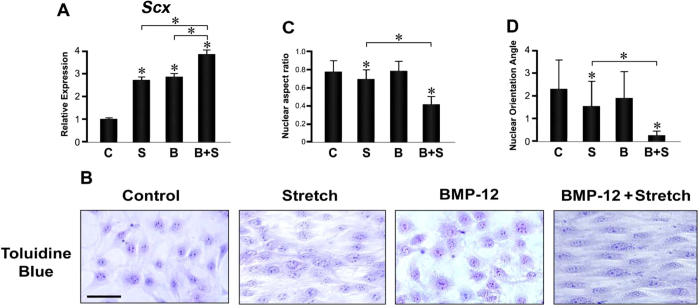
Compound effects of BMP-12 and cyclic loading on the tenocytic differentiation of C3H10T1/2 stem cells.(A) Induced expression of Scx by BMP-12 and cyclic stretch loading. Cells were left untreated or treated with BMP-12 alone, or cyclic loading alone, or BMP-12 plus cyclic loading. After incubation, cells were harvested and analyzed for Scx mRNA expression by RT-qPCR. Data are expressed as mean ± S.D. (n = 3). *p < 0.05. (B) BMP-12 and stretch loading induced cell morphological changes. Cells were treated as in (A) and stained with toluidine blue. (C) Nuclear aspect ratio: width vs length of nucleus; (D) Nuclear orientation angle: deviation of nuclear axis from average axis. *p < 0.05. C: Control, B: BMP-12 only, S: stretch loading only, B + S: BMP-12+stretch loading.